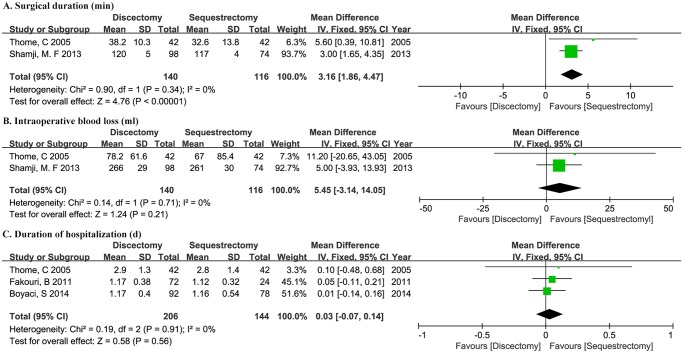
Forest plot illustrating operative time (A), intraoperative blood loss (B), hospitalization duration (C) of meta-analysis comparing discectomy with sequestrectomy.